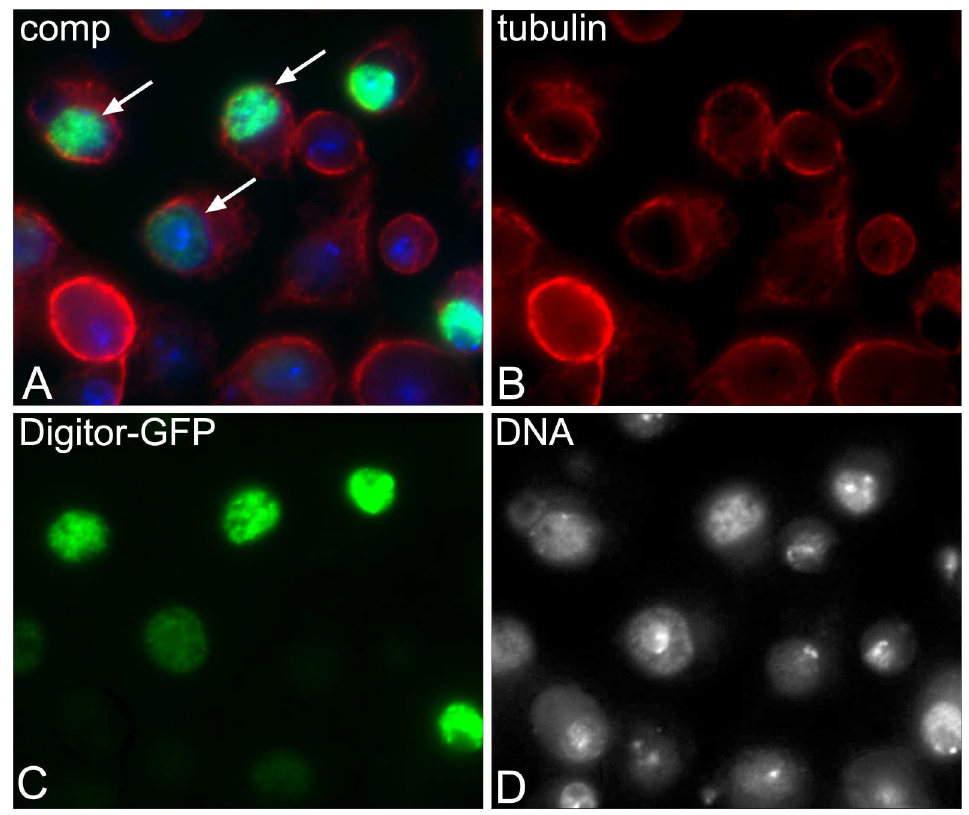
Fig 2. Digitor/dASCIZ localizes to the nucleus. (A-D) S2 cells transiently transfected with a GFP-tagged Digitor construct were fixed and labeled with antibodiesto GFP (in green), tubulin (in red), and Hoechst for DNA (in blue/grey). In the composite image (A) the nuclear localization of Digitor-GFP is indicatedby